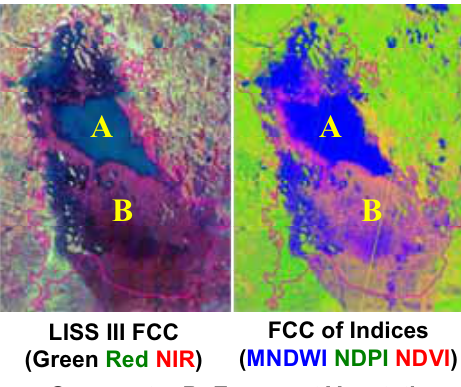
Figure 2: IRS LISS III FCC of the Nalsarovar Lake area along with FCC of indices highlighting accurate detection of